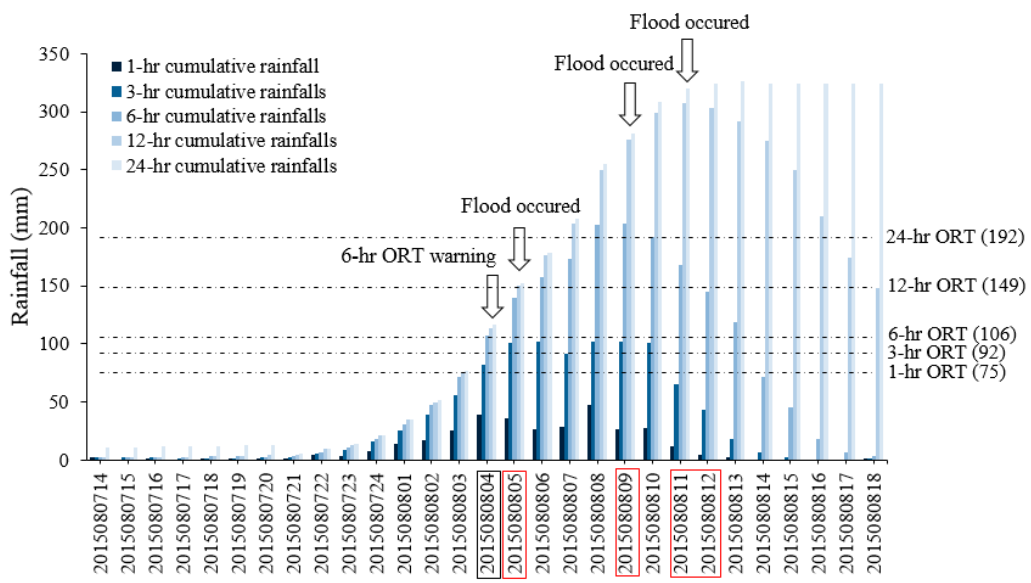
Figure 10. The CSI results at the Gongguan (C1A730) rain gauge in the Daan district: ( a ) the rainfall thresholds with 1-h and 3-h durations with constant values of ORTs with 6-, 12- and 24-h durations; ( b ) the rainfall threshold with 1-h duration; ( c ) the rainfall threshold with 3-h duration; ( d ) the rainfall threshold with 1-h and 3-h durations.